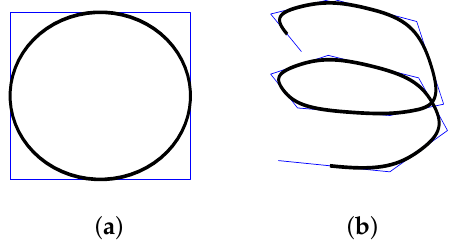
Figure 1. An example of analytic curves produced by application of a generalized subdivision scheme of order 3; ( a ) circle, ( b ) helix.